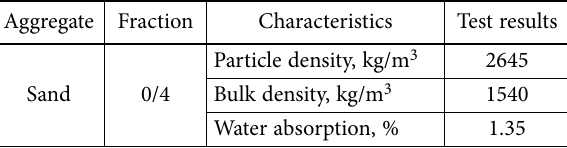
Class of admixture LS Superplasticiser based on synthetic polycarboxylate Superplasticiser based on modified acrylic polymers